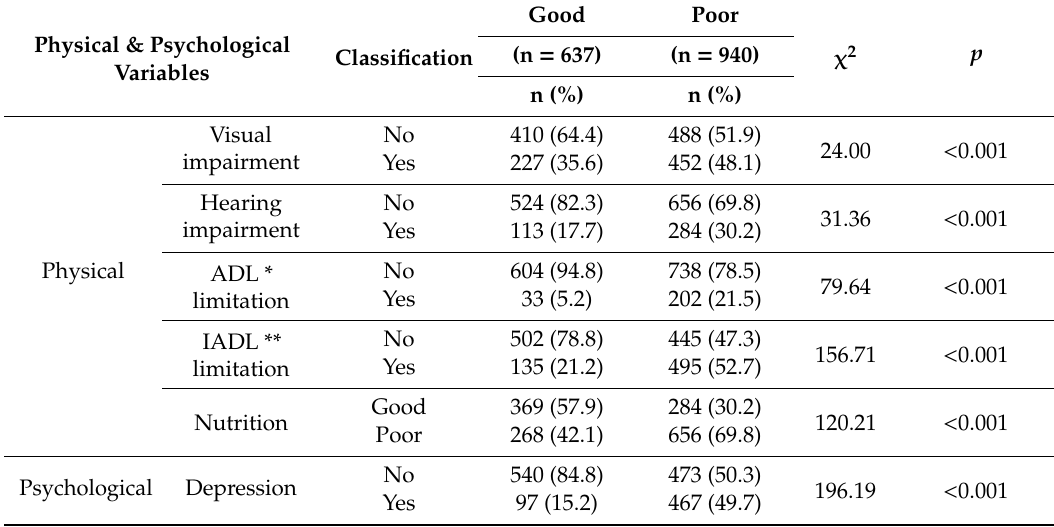
Table 2. Di ff erences in physical and psychological characteristics between those with good and those with poor self-reported health statuses (n = 1577).